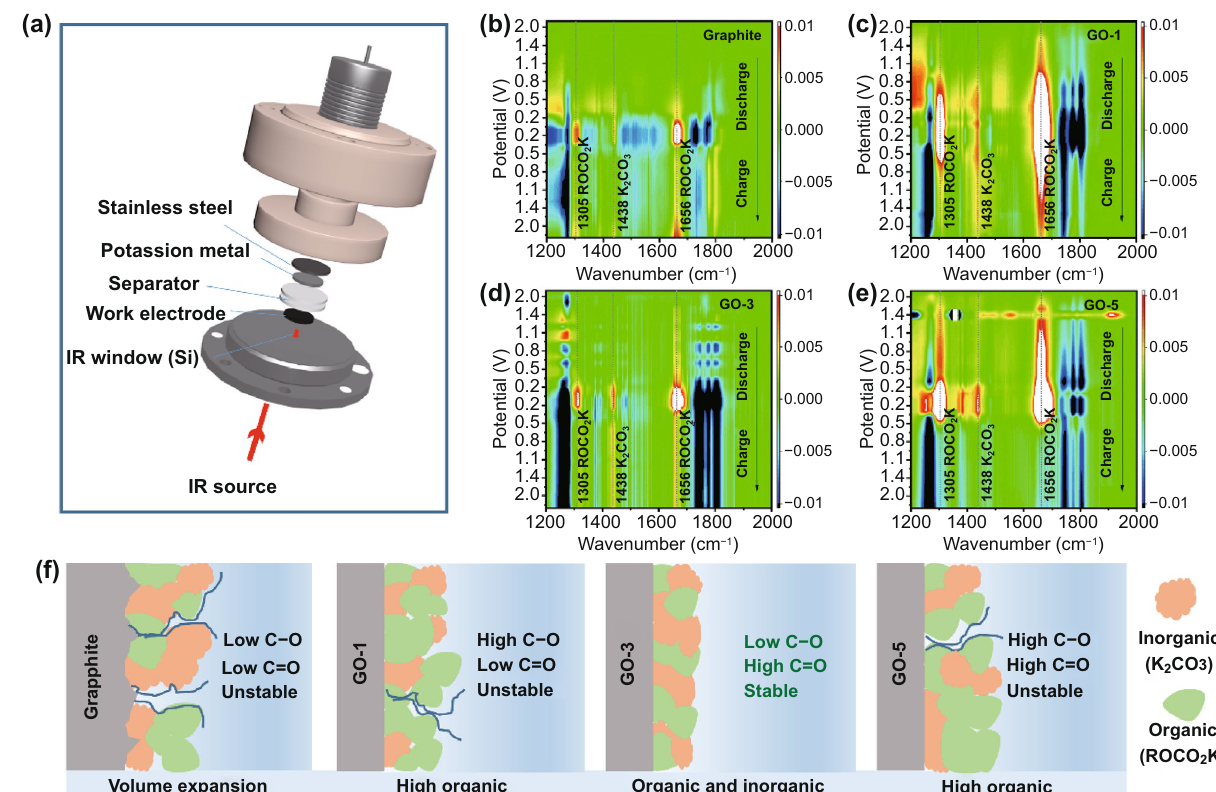
Fig. 3 In situ FT-IR analysis. a Schematic representative of the in situ FT-IR spectroelectrochemical cell. FT-IR spectra of b Graphite, c GO-1, d GO-3, e GO-5. f Schematic diagram of the SEI